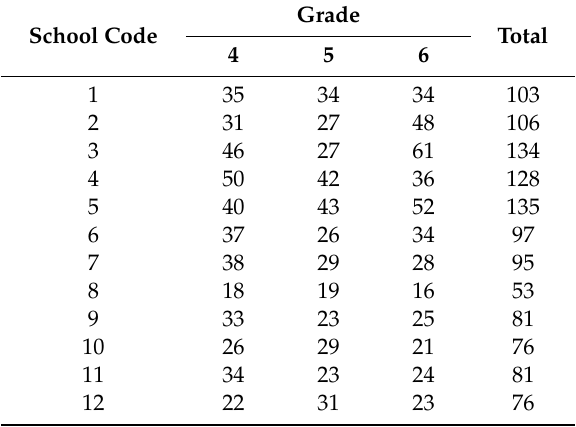
Table A1. The numbers of student participants by school and